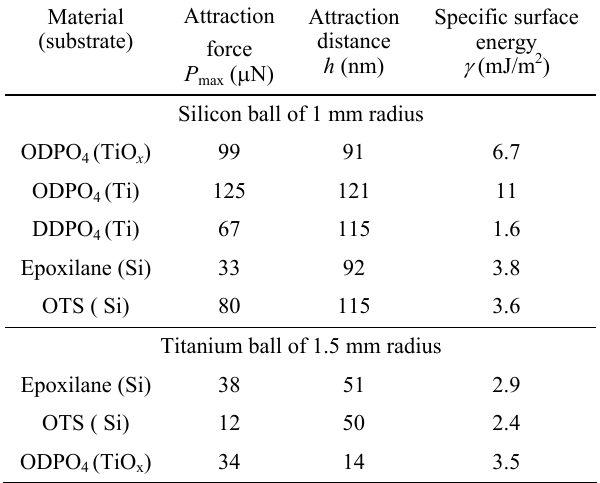
Table 4 Adhesion characteristics of polymer brush layers measured by CAM.